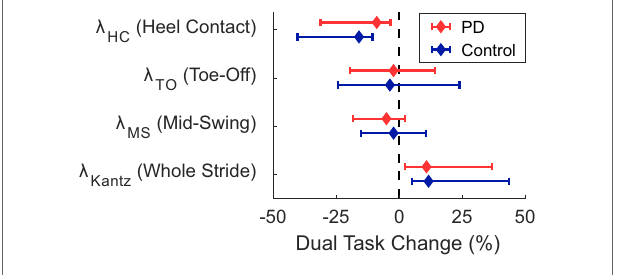
FigUre 1 | Median dual-task changes (DTC) as percentages (%DTC) and IQRs for phase-dependent local dynamic stability (LDS) measures calculated at (1) heel contact—weight transfer, λ HC , (2) toe off—early swing, λ TO , and (3) single-support—mid swing, λ MS , and traditional LDS calculated at all points within a stride, λ Kantz . DTCs were calculated as a percentage change with respect to single-task gait. *Phase-dependent LDS during heel contact— weight transfer, λ HC , was significantly different between groups whether calculated as a linear change (see Table 3 ), or as a percentage change. Group differences in DTCs as percentages were not tested on other stability outcomes as the group*task interactions were not significant in the initial linear mixed models. FigUre 2 | Median dual-task changes (DTC) as percentages (%DTC) and